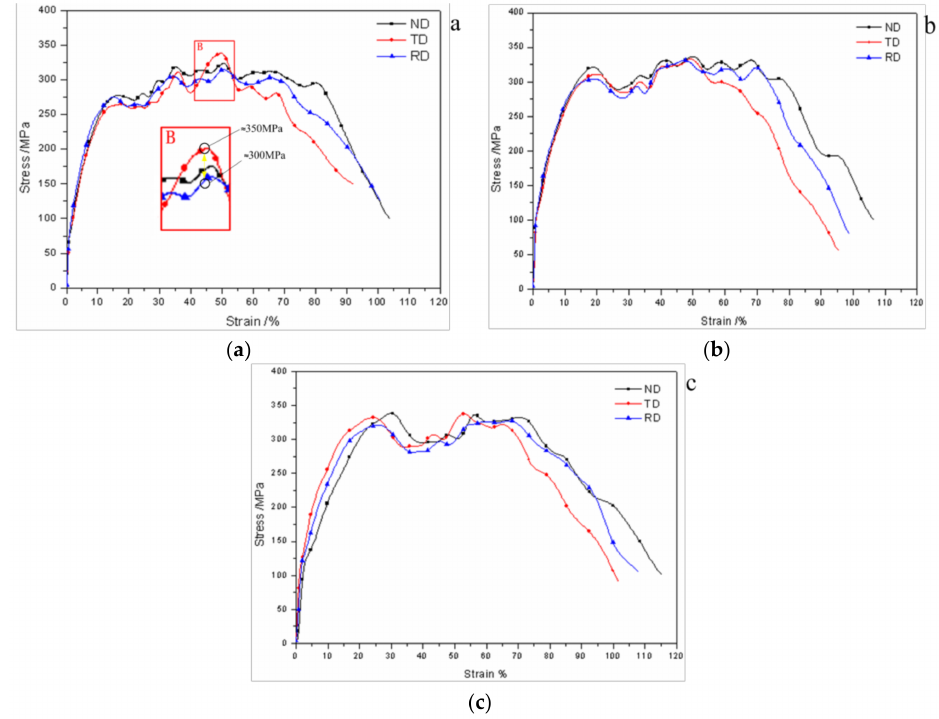
Figure 9. Dynamic stress-strain curves of different strain rates: ( a ) 2.5 × 10 4 s − 1 ; ( b ) 3.5 × 10 4 s − 1 ; ( c ) 4.5 × 10 4 s − 1